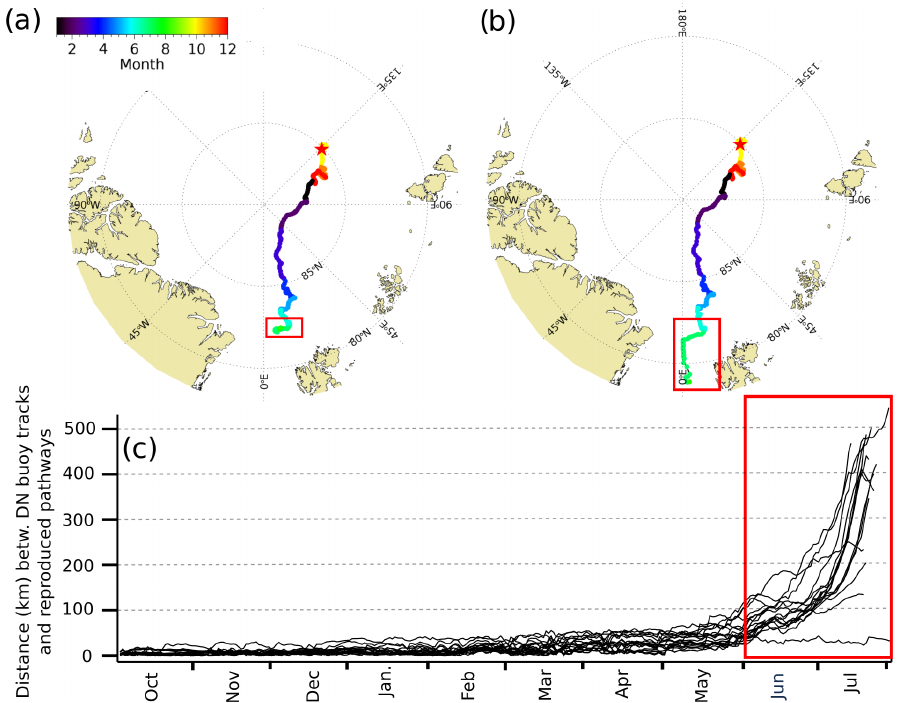
Figure 2. Comparison of MOSAiC CO and DN buoy tracks with IceTrack results. (a) Reproduced pathway of the CO with IceTrack. (b) Real (GPS-based) track of the CO. (c) Distance between 23 DN buoys (source: https://seaiceportal.de, last access: 18 August 2021) deployed on sea ice in the vicinity of the CO at the beginning of October2019 and their reconstructed trajectories. Deviation between real and virtual tracks is small. Only once buoys enter the Fram Strait (beginning of June (day 240) at 82.5 ◦ N), does the distance gradually increase (red